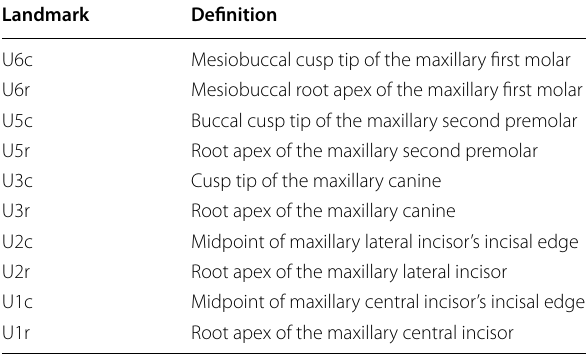
Table 1 Definitions of the landmarks in the